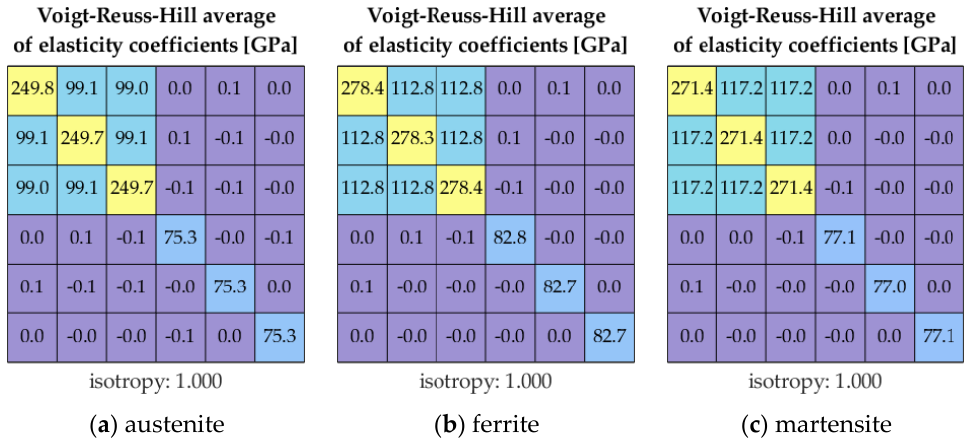
Figure 11. ( a ) The Voigt-Reuss-Hill averaged elasticity matrix of the samples of ( a ) pure austenite; ( b ) pure ferrite; and ( c ) pure martensite. All values are obtained from samples at a temperature of 27 °C. The elasticity matrices are independent of the grain size.